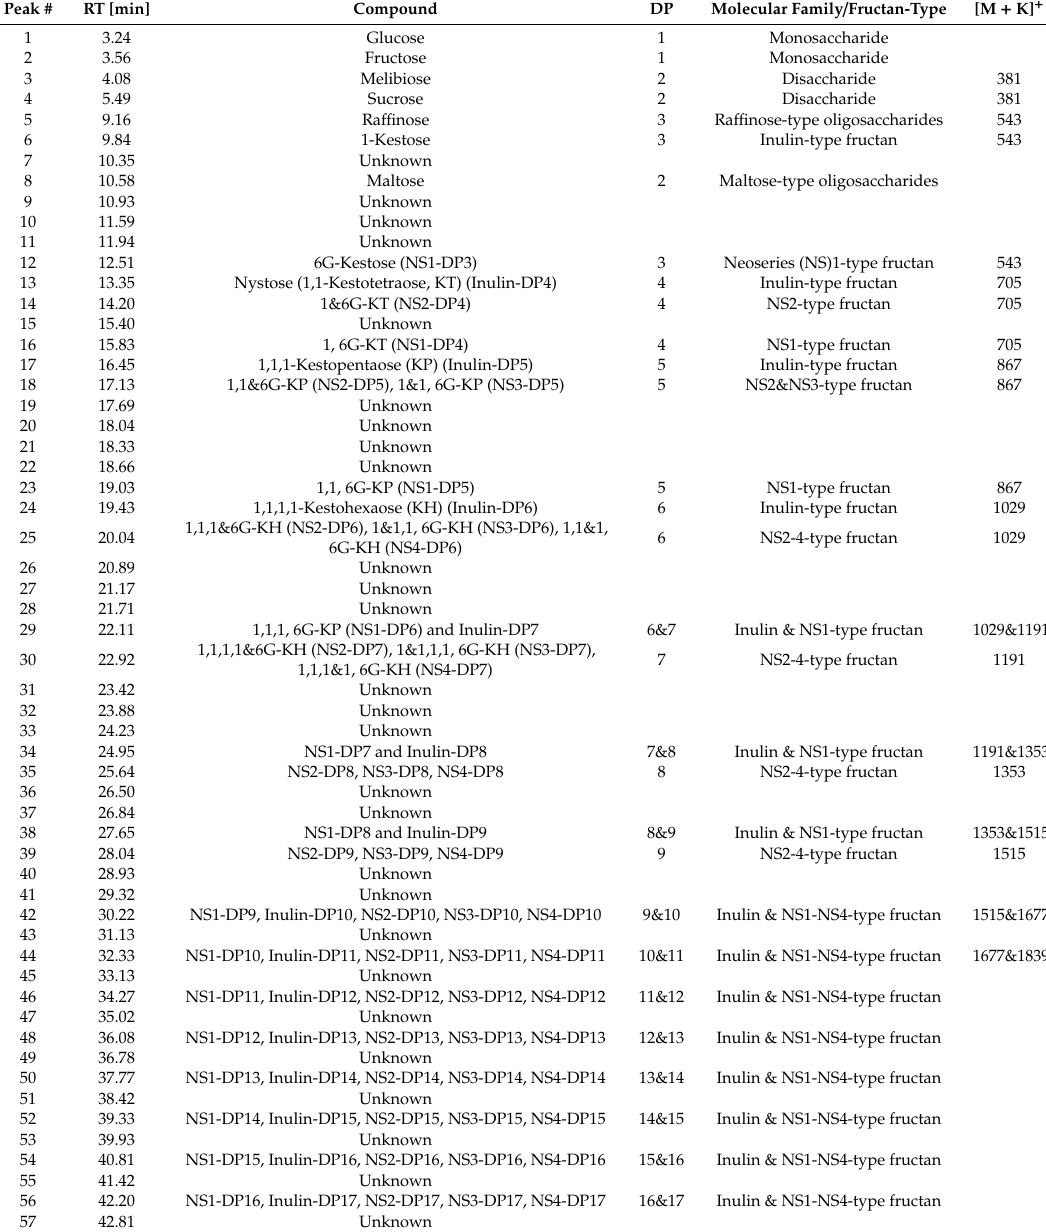
Table 1. Oligosaccharide annotation information. The 57 metabolites are listed with their retention time (RT), the determined degree of polymerization (DP), the molecular family and fructan-type and the main molecular ion [M + K] + determined by mass spectrometry